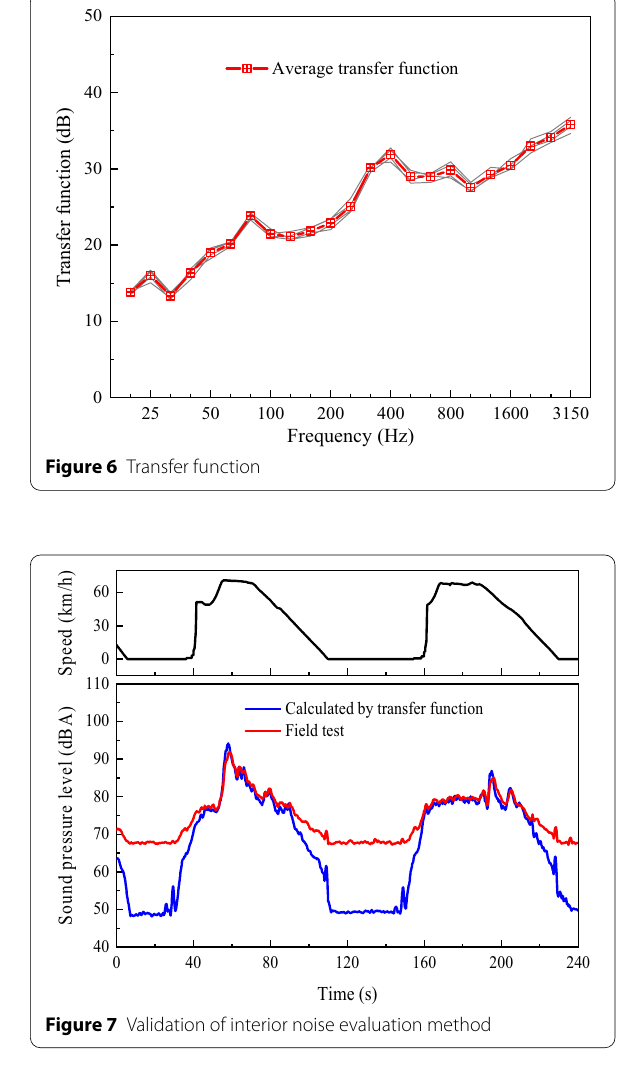
Figure 7 Validation of interior noise evaluation